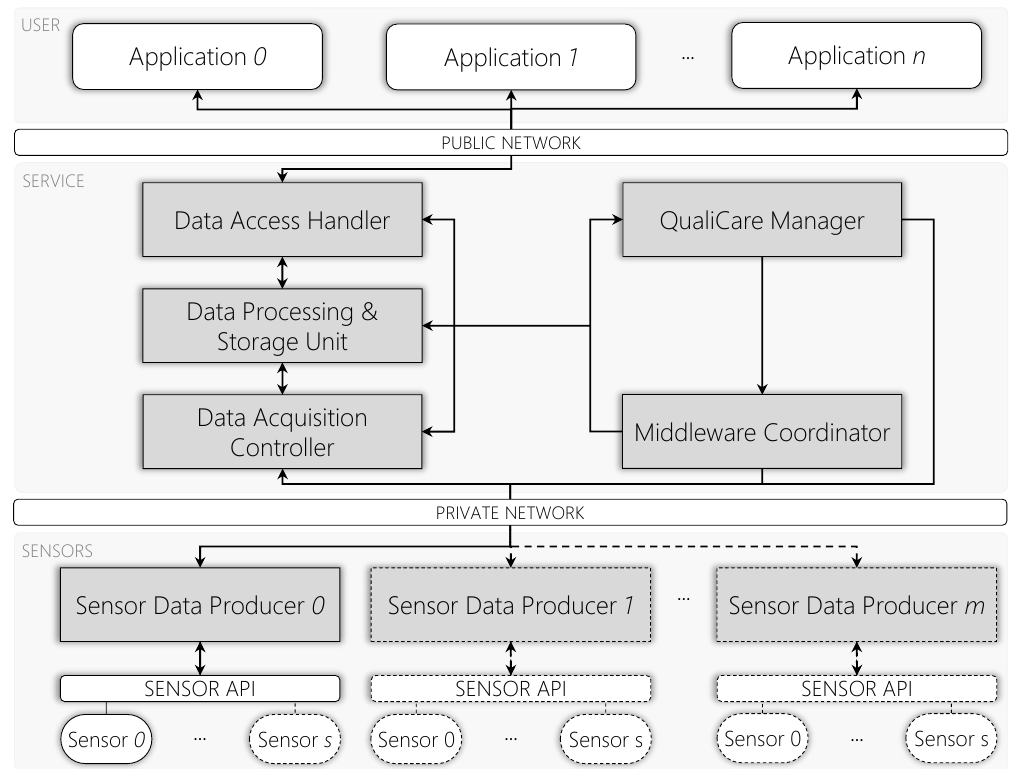
Figure 3. QualiCare architecture presenting the middleware in the Service level and additional modules in the Sensor level inside the OR. Arrows represent the communication direction in the following